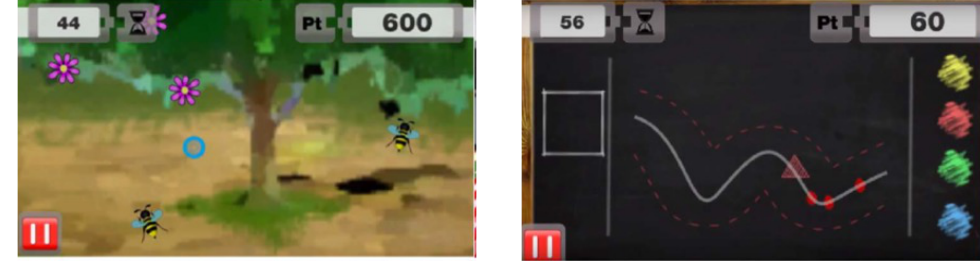
Fig. 2. Two-dimensional Environments in games from the Rehab@Home system (Jonsdottir et al., 2018)